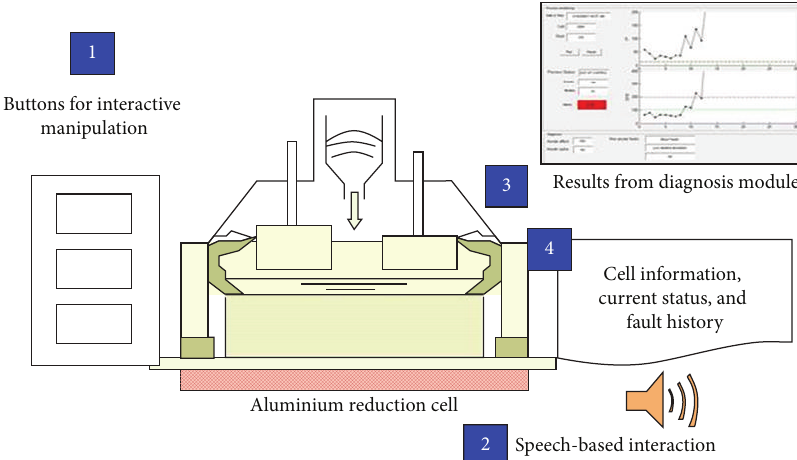
Figure 9: Augmented view of the real world with superimposed information for four main